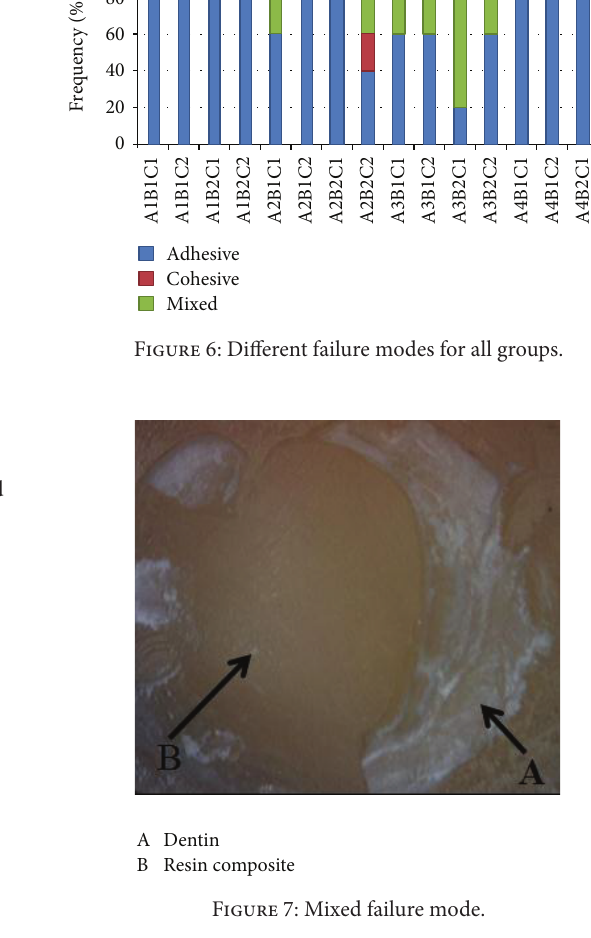
Figure 7: Mixed failure